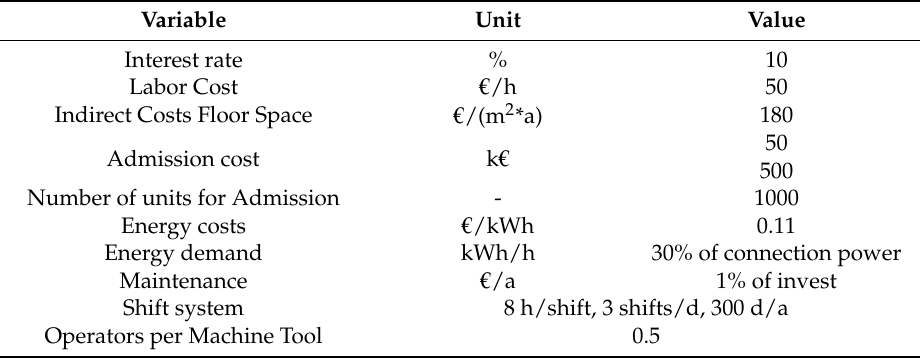
Table 2. General assumptions for the economical assessment.